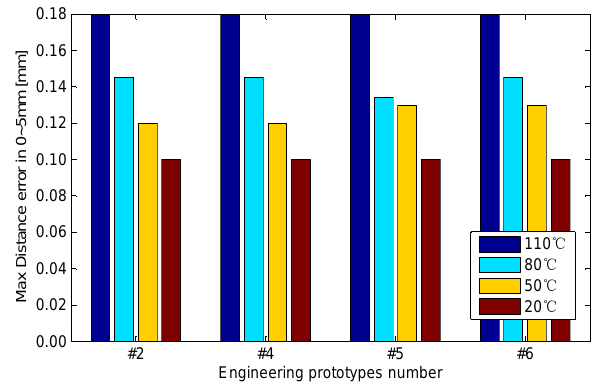
Figure 20. Max distance error of the four engineering prototypes at 0–5 mm.